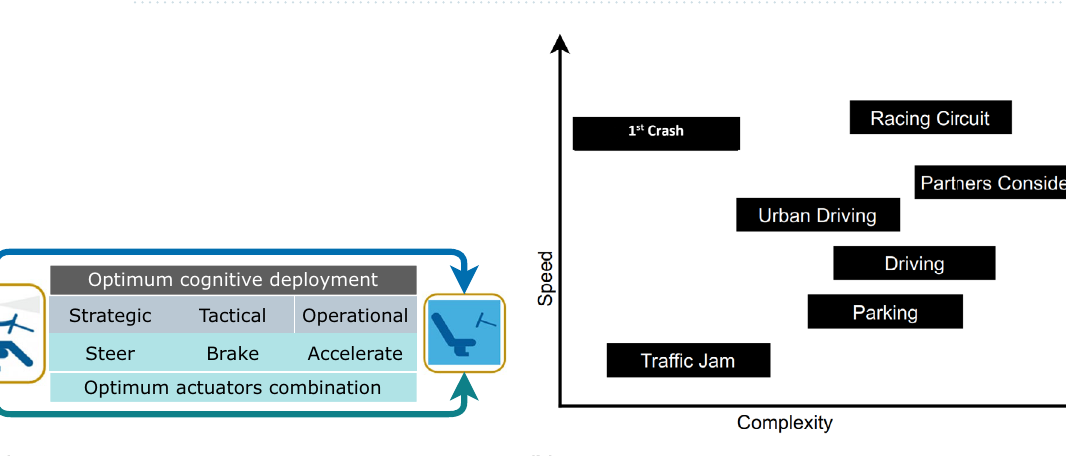
Figure 2. The overview of work flow of MVCCA in AVs.